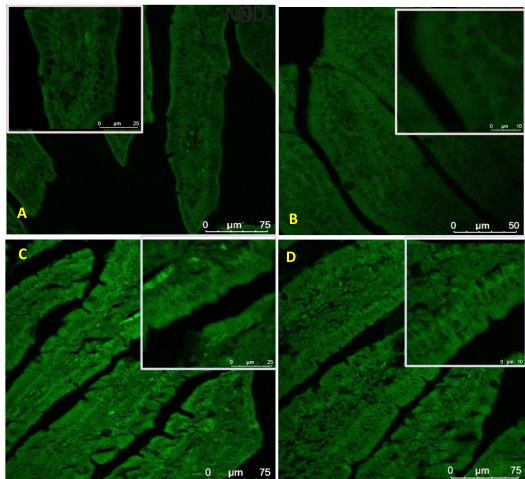
Figure 15. The impact of high-fat diet treatment on ZO-1 expression in mouse jejunum. The HFD-fed group showed lower expression of ZO-1, a key tight junction protein. Treatment with MESK and Orlistat restored the expression of ZO-1 ( A : ND: normal diet, B : HFD: high-fat diet, C : HFDO: HFD + Orlistat, D : HFDM: HFD + MESK). Claudin-1 expression in the intestine was measured using standard DAB-H 2 O 2 immunohistochemistry protocols. Claudin-1 is tetraspan protein present on the tight junctions and helps in pore formation between the adjacent epithelial cells and controls paracellular permeability. Owing to its critical role in paracellular permeability, we analyzed the expression of Claudin-1 in mouse jejunum. It was observed that HFD reduced the expression of Claudin-1 in jejunum (Figure 16B). However, treatment with both Orlistat and MESK restored the expression of Claudin-1 in the jejunum (Figure 16 C, D). Taken together, MESK and Orlistat restored the normal intestinal expression of both ZO-1 and Claudin-1 in the jejunum, and hence prevented the damaging effects of HFD on the intestine and restored normal intestinal permeability.